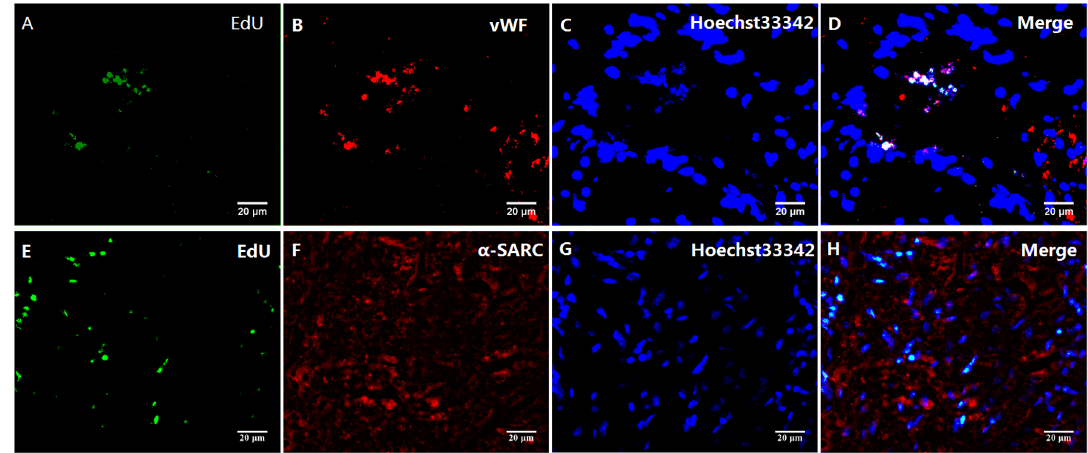
Figure 2. The fate of engrafted HGF-MSCs. (A–D) Double-immunofluorescence staining for viable HGF-MSCs in the infaction border zone four weeks after transplantation. The merged fluorescence indicates colocalization of EdU and vWF, suggesting that the HGF-MSCs exhibited a tendency to differentiate into vascular endothelial cells. (E–H) There was a lack of evidence of cardiomyogenic differentiation based on the absence of a -SARC/ EdU colocalization.